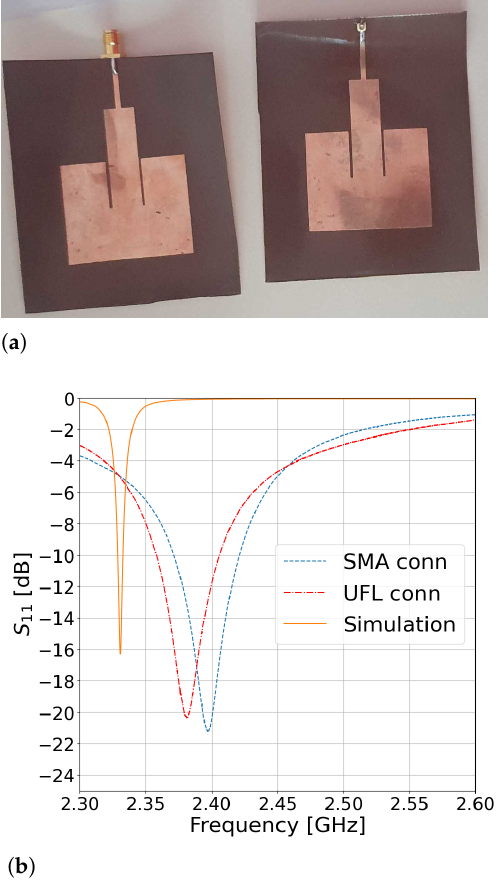
Figure 2. The feasible IRMA models: ( a ) fabricated with an SMA and a U.FL connector; ( b ) the S 11